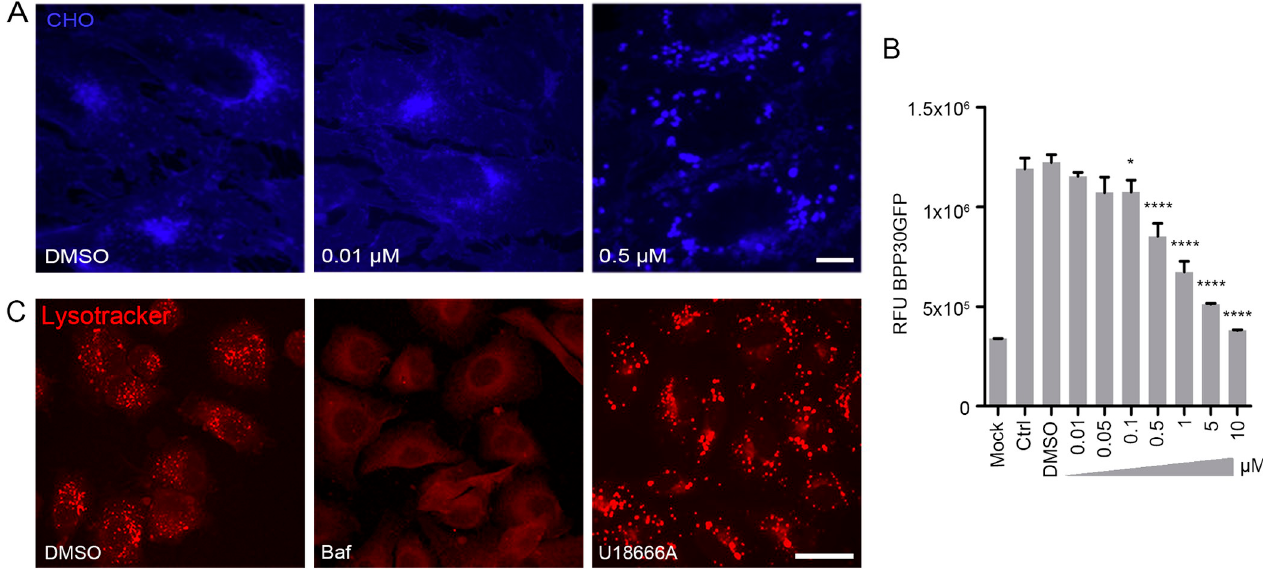
Fig 1. Cholesterol efflux arrest and inhibition of ASFV infectivity. (A) Treatment with increasing concentrations of U18666A chemical compound altered the distribution of unesterified cholesterol (CHO) in Vero cells (filipin; blue). Scale bar: 10 μ M. (B) Cells pre-treated with increasing concentrations of U18666A compound and infected with recombinant ASFV BPP30GFP for 16 hpi. GFP fluorescence intensity was measured using a plate reader. Graph represents mean ± sem of 3 independent experiments. Statistically significant differences are indicated by asterisks ( ���� p < 0.0001, � p < 0.05). (C) Visualization of acidic vesicles with lysotracker (red) in Vero cells treated with U18666A drug or controls. These acidic vesicles were absent after treatment with lysosomotropic drugs (Scale bar: 25 μ M).